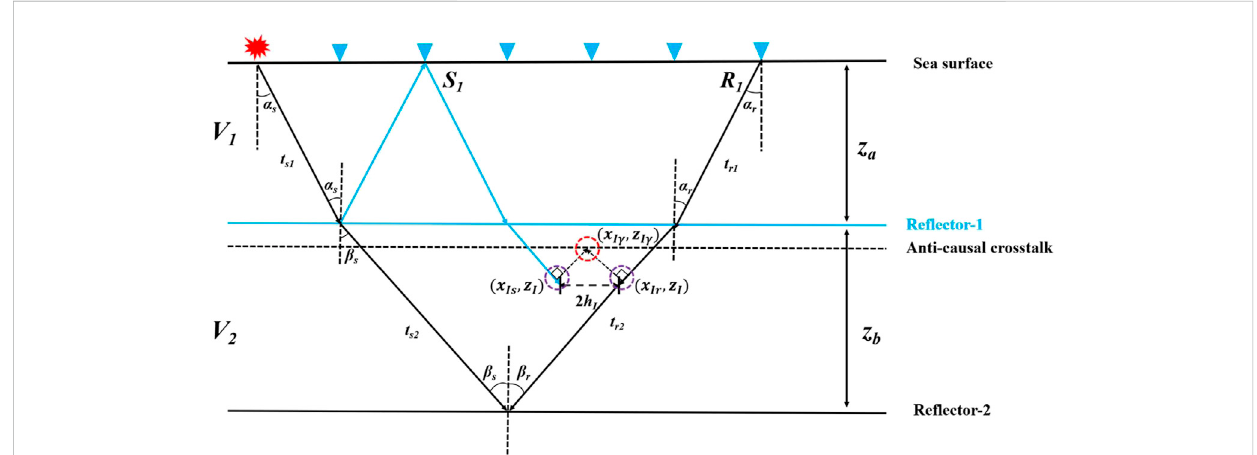
FIGURE 4 Ray paths for generating anti-causal crosstalk. V 1 and V 2 are the velocity of the fi rst and second layers, respectively. z a and z b are the depth of the re fl ector-1 and re fl ector-2. α s and α r are the incident and emergent angles of the source and receiver rays with respect to the vertical direction. β s and β r aretheanglesofthesourceandthereceiverrayswithrespecttotheverticaldirectionafterrefractionbythere fl ector-1. γ isthehalf-apertureangle,which is equal to ( β s + β r )/2. h I is the subsurface half-offset, which is equal to ( x Ir - x Is )/2.